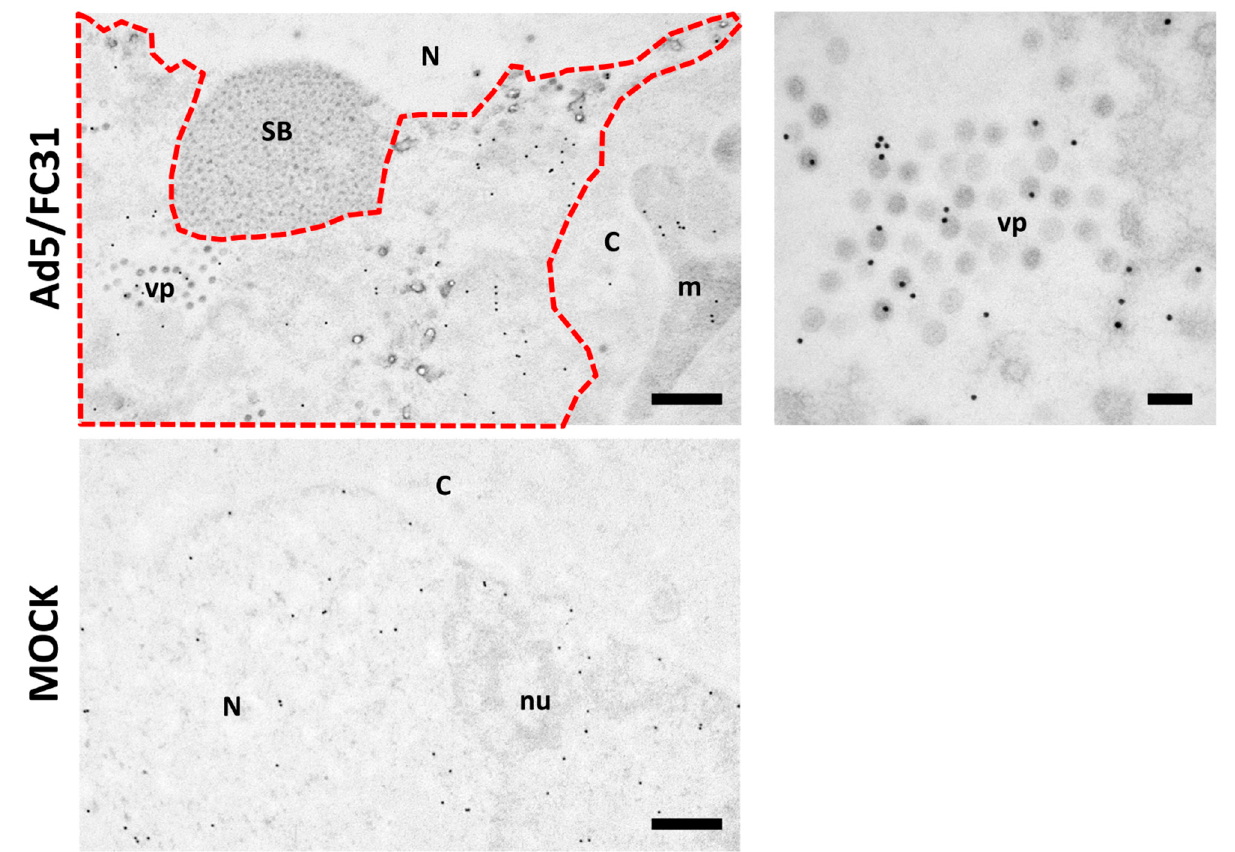
Figure 8. BrdU labeling for freeze-substituted samples. HEK 293 cells infected with Ad5/FC31 (MOI 50), or uninfected, as indicated. BrdU (25 µg/mL) was added at 18 and 25 hpi. The cells were fixed at 48 hpi. Nucleus (N), nucleolus (nu), cytoplasm (C), viral particles (vp), speckled body (SB), mitochondria (m), replication center (red dotted line). Scale bar: 500 nm in the left panels, 100 nm in the right hand side panel.